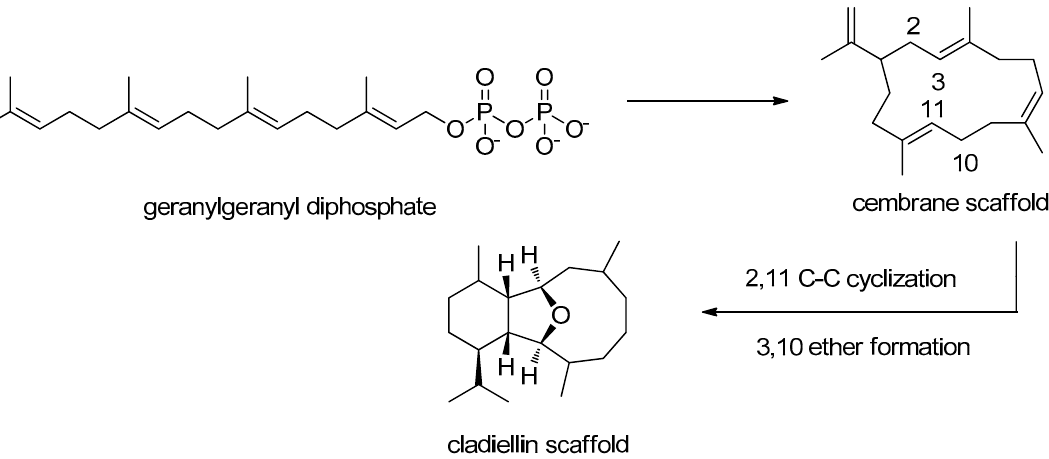
Figure 2. Biosynthetic pathway to cembranoid and cladiellin cores [23].